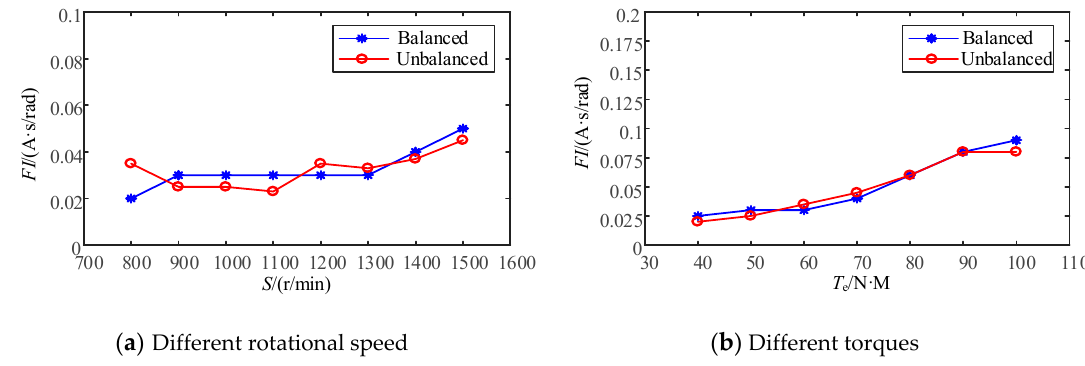
Figure 9. Fault indicators when the voltage is balanced and when there is a voltage imbalance.